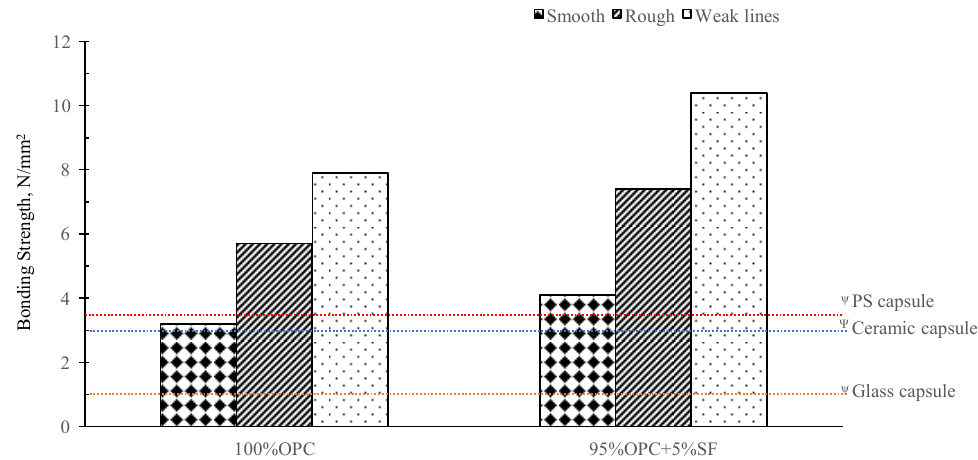
Figure 10. Bonding strength characteristic of capsules with variations of mortar mix combinations ( ψ Hilloulin et al. (2015)).